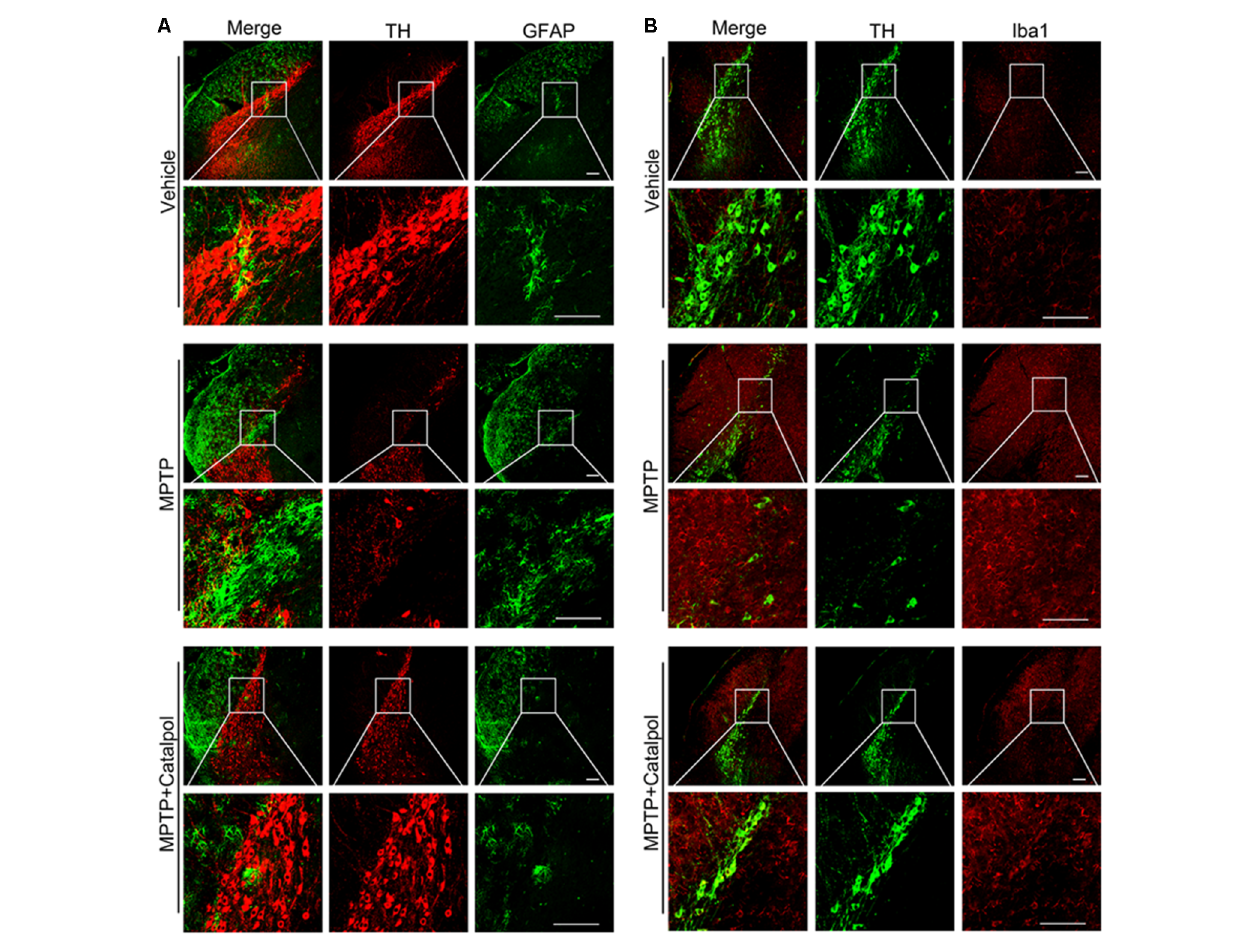
FIGURE 6 | Catalpol treatment suppresses microglia and astrocyte activity induced by MPTP. (A) Frozen sections of the SN were labeled with anti-TH (red) and anti-GFAP (green) antibodies to detect DA neurons and astrocyte activity, respectively. Scale bar = 100 µ m. (B) Brain sections were labeled with anti-TH (green) and anti-Iba1 (red) antibodies to assess microglia activity in the SN. Scale bar = 100 µ m; n =